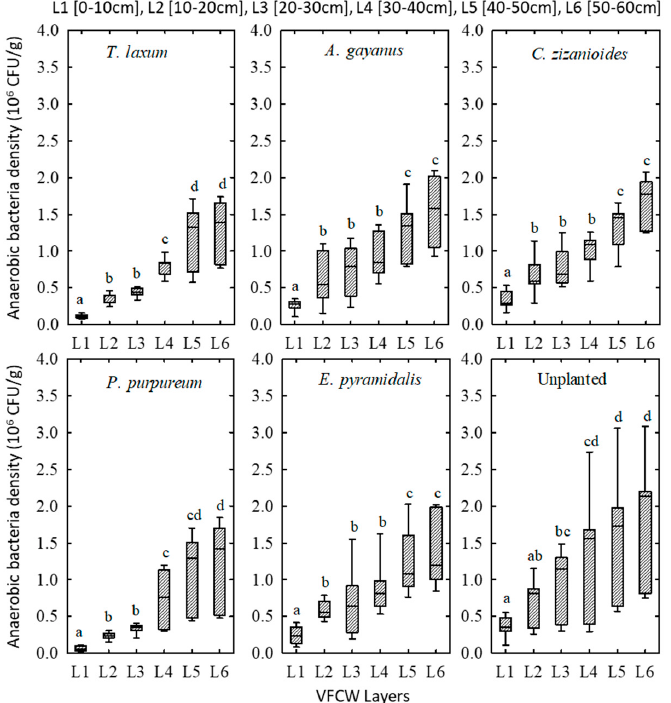
Figure 5. Vertical profile of anaerobic bacteria density in the different substrate layers of the pilot VFCW beds from the upper to the bottom layers: L1 [0–10 cm], L2 [10–20 cm], L3 [20–30 cm], L4 [30–40 cm], L5 [40–50 cm], L6 [50–60 cm]. Box-plots bearing the same letter indicate no significant difference ( p > 0.05).